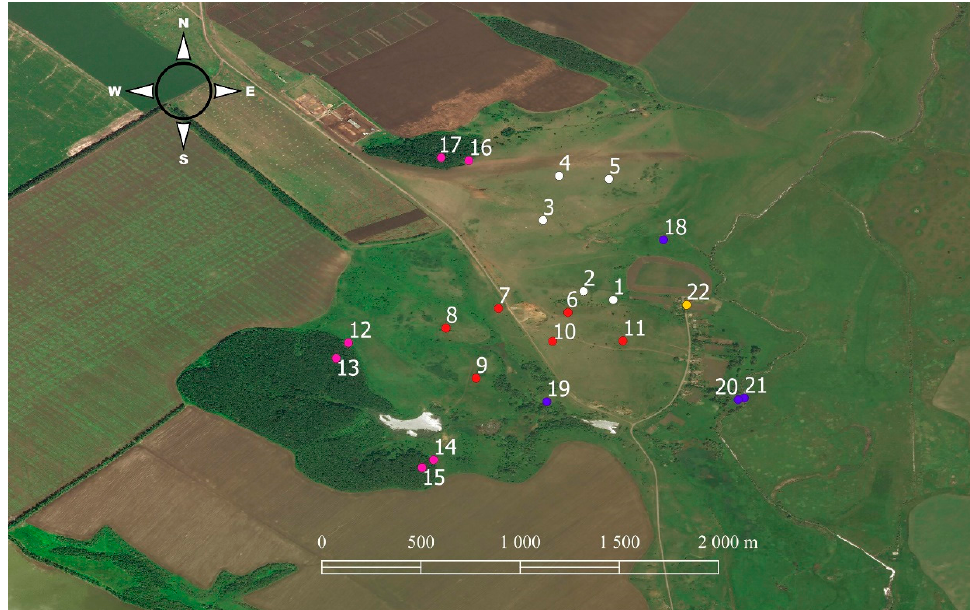
Figure 1. Map of collecting localities. Dry grasslands: 1–5 are monitoring plots on the gully bottoms and slopes, while 6–11 are other gully slopes; forests: 12–17; wetlands: 18–21; farm houses: 22. For the locality description, see Table 1. Table 1. Sample plots in the Velykoburlutskyi Steppe Regional Landscape Park.